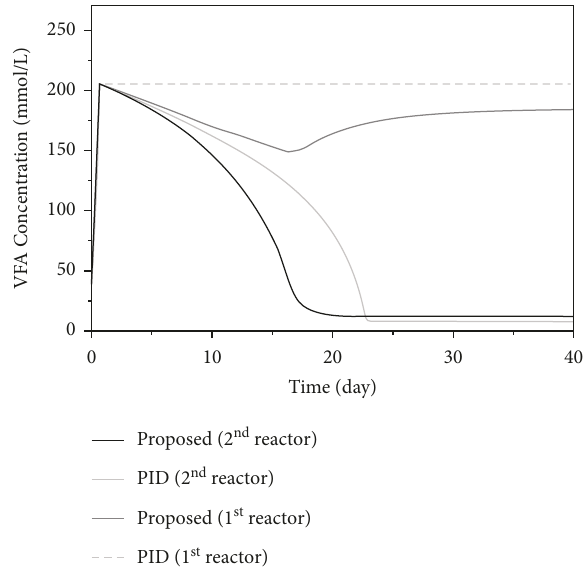
Figure 5: The VFA concentration responses of the closed-loop system.